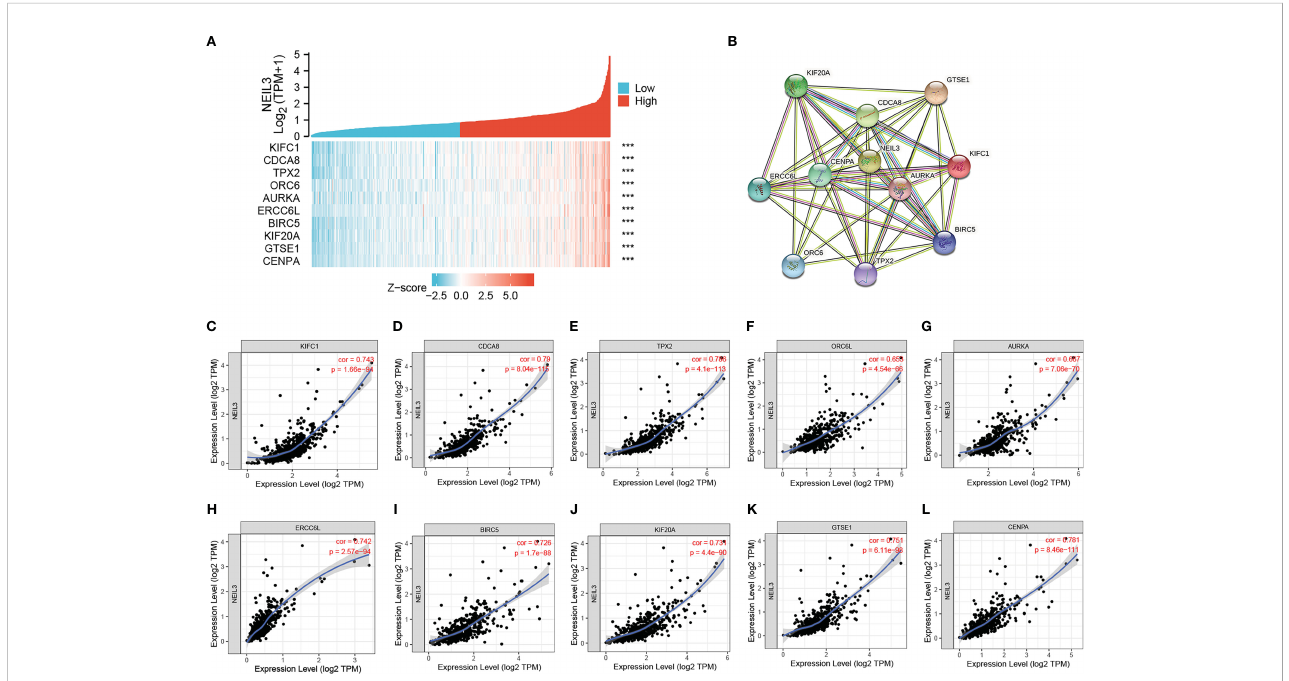
FIGURE 5 Correlation analysis of genes coexpressed with NEIL3. (A) The top ten genes positively correlated with NEIL3 were shown in the heatmap. (B) The PPI network of the top ten genes was established using STRING. (C – L) The correlation between NEIL3 and related genes was analyzed by the TIMER.0 database. Results show that NEIL3 is remarkably relevant to KIFC1 (cor = 0.743, P = 1.66e-94), CDCA8 (cor = 0.79, P = 8.04e-115), TPX2 (cor = 0.786, P = 4.1e-113), ERCC6L (cor = 0.742, P = 2.57e-94), BIRC5 (cor = 0.726, P = 1.7e-88), KIF20A (cor = 0.731, P = 4.4e-90), GTSE1 (cor = 0.751, P = 6.11e-98), CENPA (cor = 0.781, P = 8.46e-111), ORC6 (cor = 0.653, P = 4.54e-66) and AURKA (cor = 0.667, P = 7.06e-70). ORC6L, Aliases for ORC6 Gene. ***, P < 0.001.